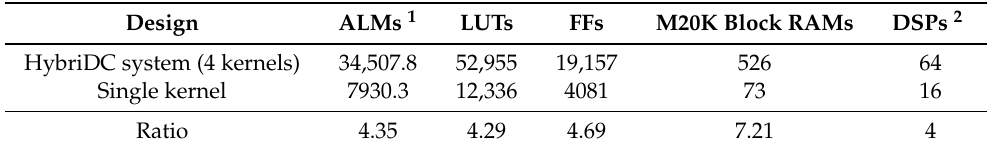
Table 5. The FPGA resource utilization comparison between the HybriDC system and the single HybriDC compression kernel.